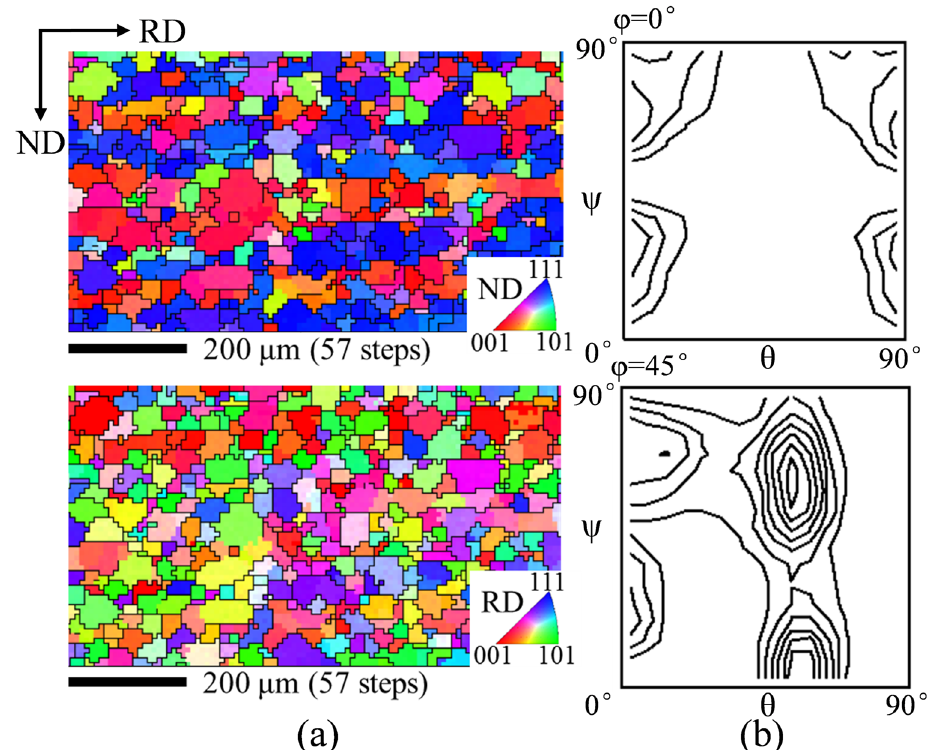
Figure 7. (a) Orientation image maps and (b) constant φ = 0° and 45° sections of ODFs (levels: 1, 2, 3...) in Fe-4.5 wt.% Si sheets after decarburization annealing at 830 °C for 89%